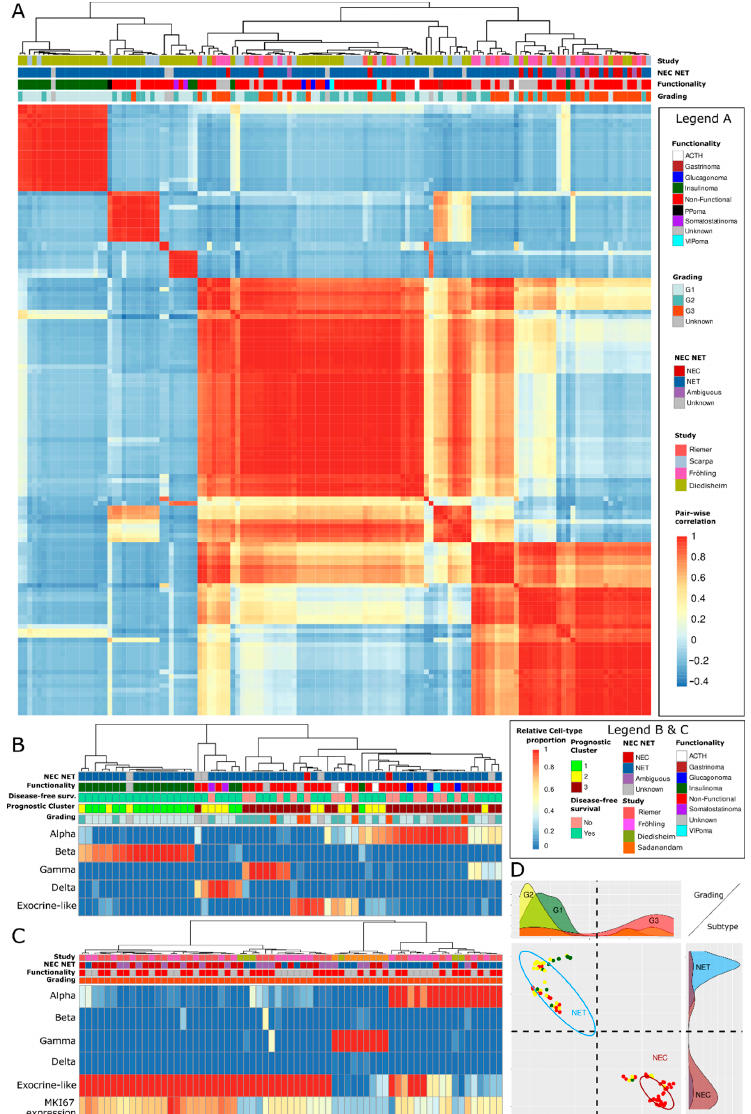
Figure 4. Overview of the relationship between deconvolution predictions and clinical characteristics. Plot ( A ): heatmap of the pairwise correlations of deconvolution results of four Bulk-RNA-seq sequencing datasets. It is shown that the panNENs do not cluster according to their study of origin but according to their NEC or NET and functionality characteristics and, to a lesser extent, grading. Plot ( B ): the deconvolution results of the low- to medium-grade Diedisheim dataset. It is shown that functional characteristics such as the classification as insulinoma are congruent with the deconvolu- tion predictions and that the prognostic clusters (3 worst, 1 best) annotated by Diedisheim et al. [17] correlate with a grouping based on deconvolution results. Disease-free survival state relates to a five-year time point. Plot ( C ): clustering heatmap of 67 high-grade G3 NETs and NECs with both pancreatic and non-pancreatic origin from all four datasets with NECs based on their cell type predic- tion. It is shown that NECs and NETs are predominantly assigned to different clusters (top left versus right cluster) regardless of their site origin or dataset, which makes their separation and classification possible, while MKI67 expression correlates with the cell type proportion predictions. Plot ( D ): UMAP projection of GEP-NENs from the Riemer, Scarpa, and Fröhling cohorts onto a two-dimensional surface according to their respective distance in the higher-dimensional space of deconvolution cell type proportions, reconstruction error, p -value, and correlation. A linear separability of NENs with different grading and NEC or NET status is possible within the space of deconvolution